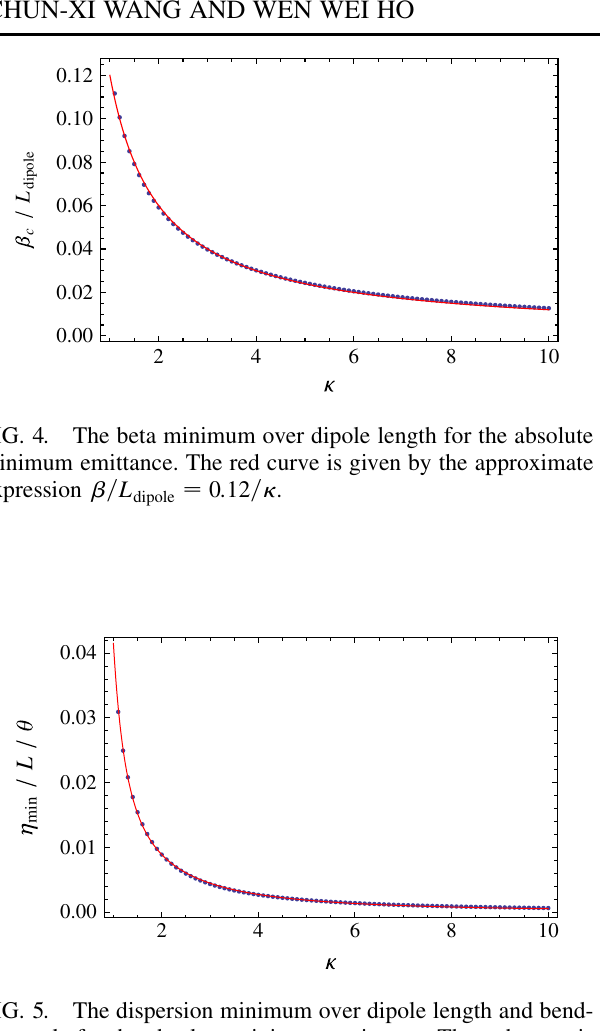
FIG. 5. The dispersion minimum over dipole length and bend- ing angle for the absolute minimum emittance. The red curve is ¼ 0 : 059 =(cid:12) 2 (cid:1) 0 : 077 =(cid:12) 3 þ 0 : 059 =(cid:12) 4 given by (cid:6)=(cid:4)=L dipole